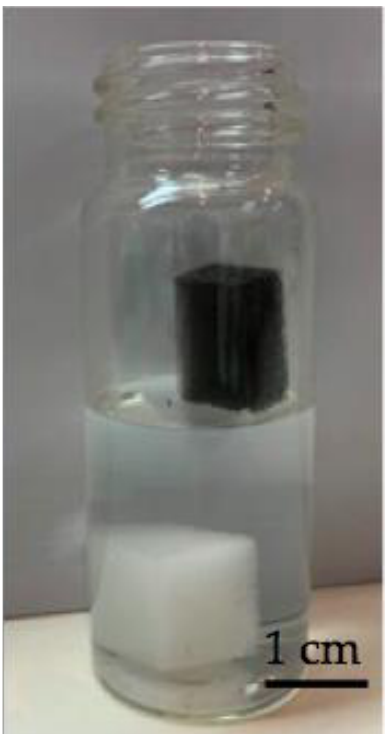
Figure 4. Pure melamine sponge and M – rGO – ascorb in contact with water. Sorption experiments with water, diesel fuel, oil and gasoline were carried out for all obtained samples. The process of organic substance sorption by highly porous materials is spontaneous and represents physical sorption [55]. The pores of materials modified with rGO are filled with air at the initial moment of time; therefore, in order to implement physical sorption, the oil needs to displace air [56,57], which occurs in the described ex- periments. Figure 5 shows the experiments ’ main step. The final step shows that the composite effectively sorbs organic liquid while practically not sorbing water.